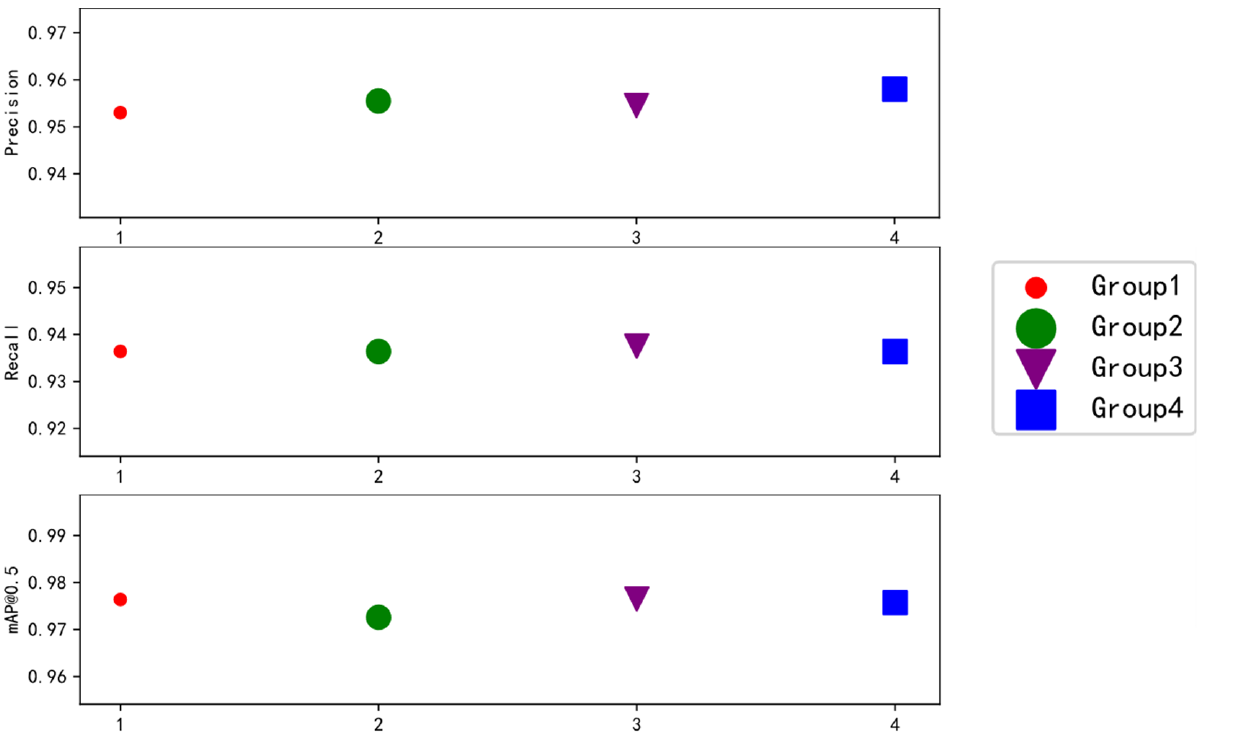
Figure 13. Ablation experiment. Each point in the figure corresponds to a set of training skills and is distinguished by different colors and shapes of the points. The comparison of the experimental results shows that when Mosaic and mixup were used, the precision, recall, F1, map, FPS, and other data improved. The results show that Group 4 worked